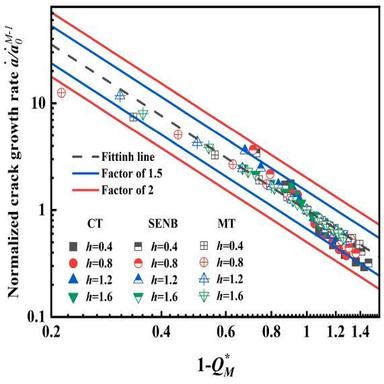
The relationship between normalized CCG rate for all mismatched specimens and (1-Q∗ M).